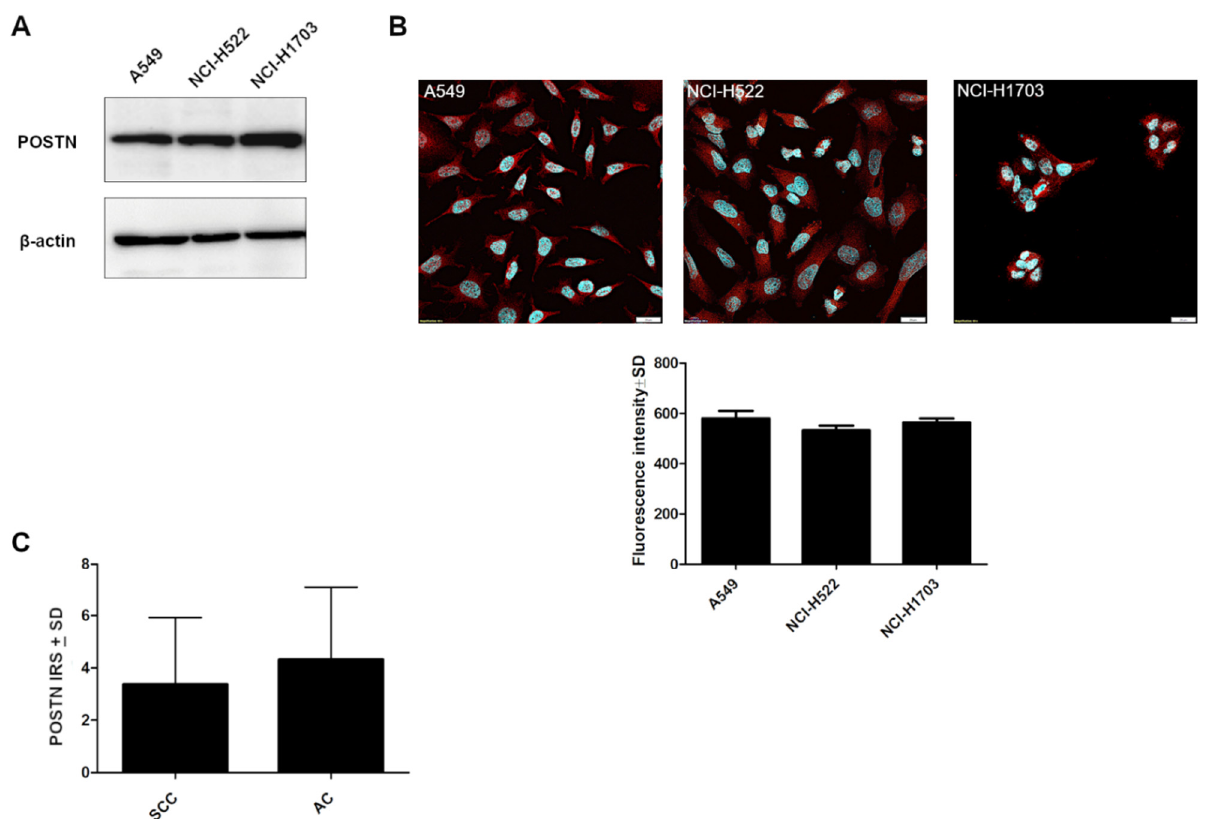
Figure 7. Characteristics of lung cancer cell lines according to periostin (POSTN) expression. ( A ) Comparison of POSTN expression levels detected by Western blot and ( B ) by confocal microscopy (fluorescence intensity) in different lung cancer cell lines (A549, NCI-H522, NCI-H1703), ( p > 0.05). Objective 60×/1.40 Oil; pinhole airy 1.25. Bar = 20 µm. ( C ) Immunohistochemical expression level of periostin (POSTN) in the tissue of particular non-small cell lung carcinoma (NSCLC) subtypes: squamous cell carcinoma (SCC) and adenocarcinoma (AC) ( p > 0.05). IRS, immunoreactive score.